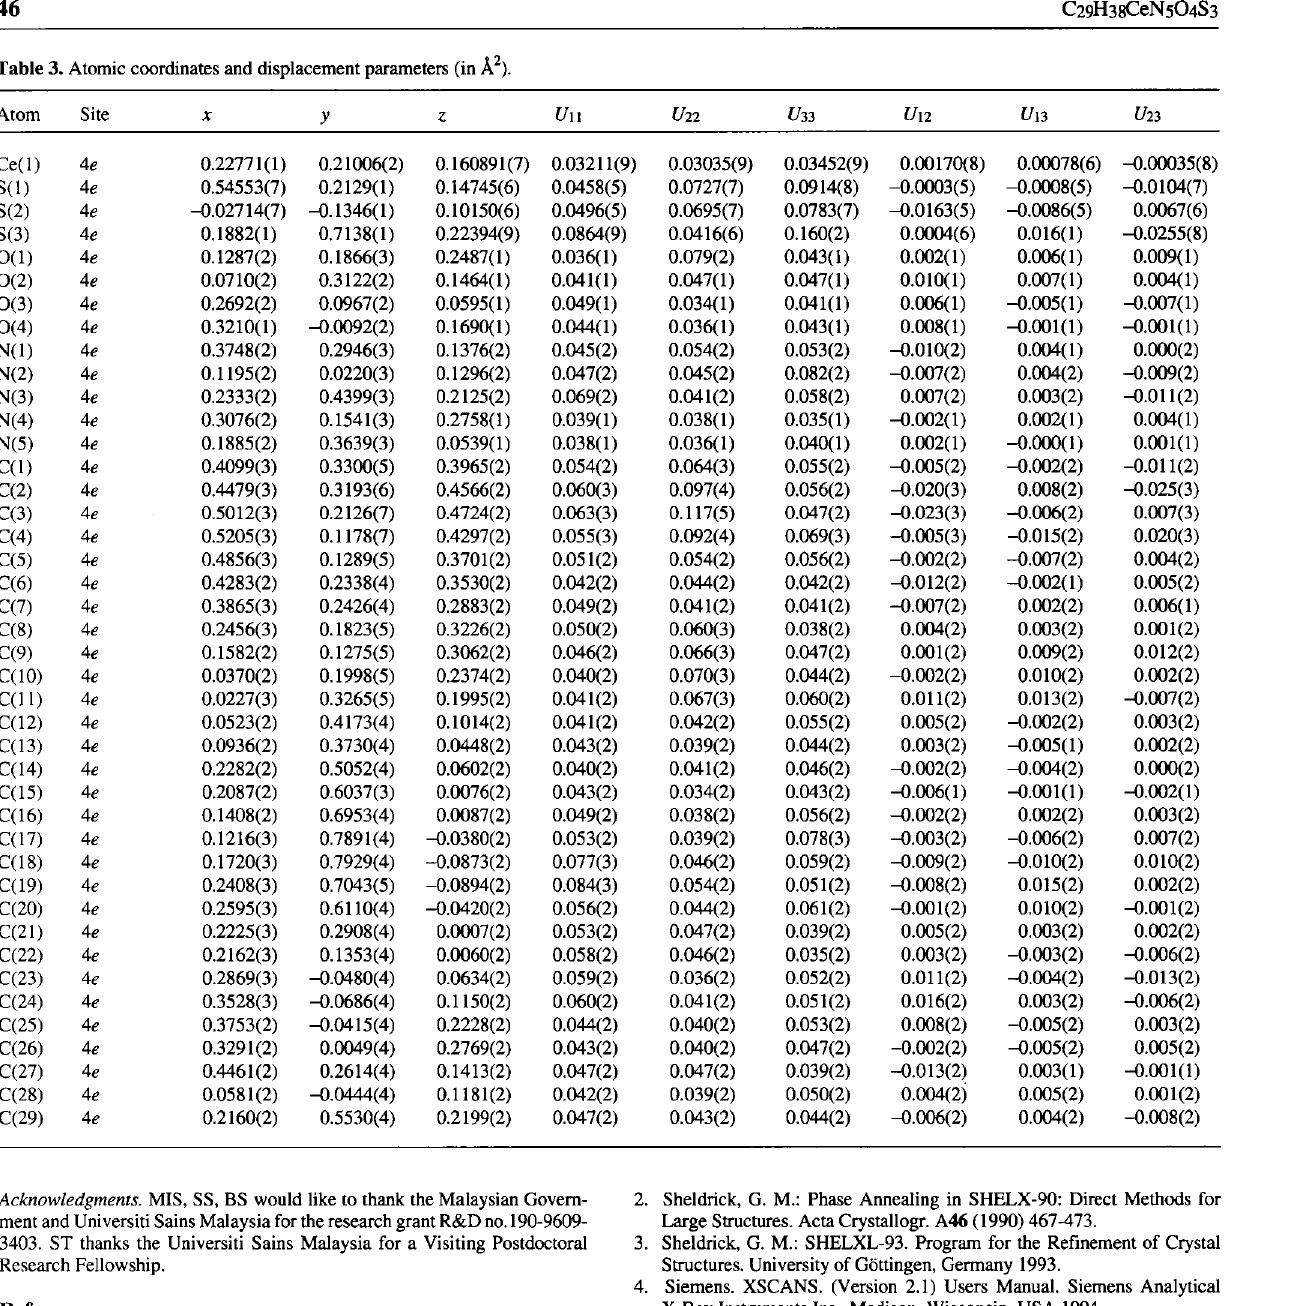
Table 3. Atomic coordinates and displacement parameters (in Â 2